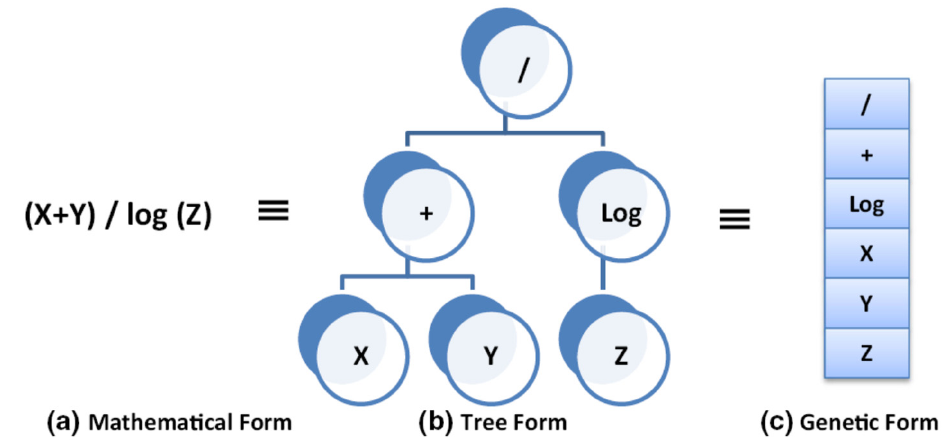
Figure 8. Coding mathematical expression in tree and genetic form.